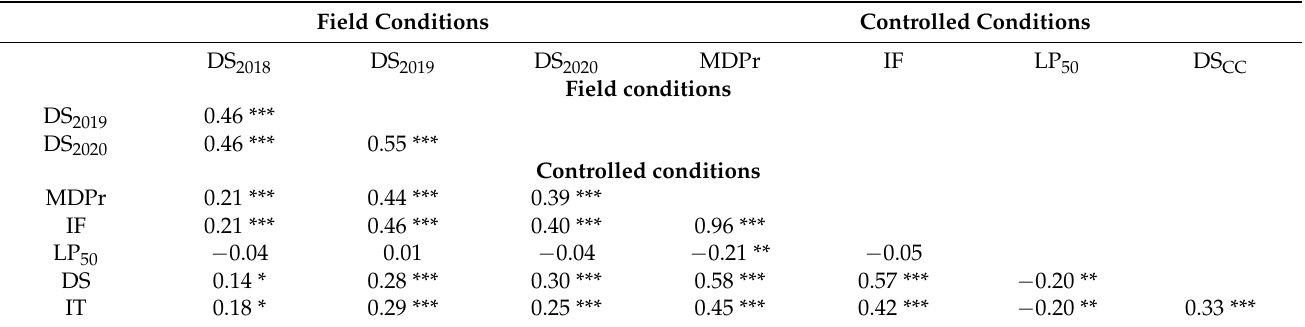
Table 3. Pearson ( p ) correlation coefficient between traits evaluated under field and controlled conditions and calculated from adjusted mean (BLUPs) values from the 320 pea